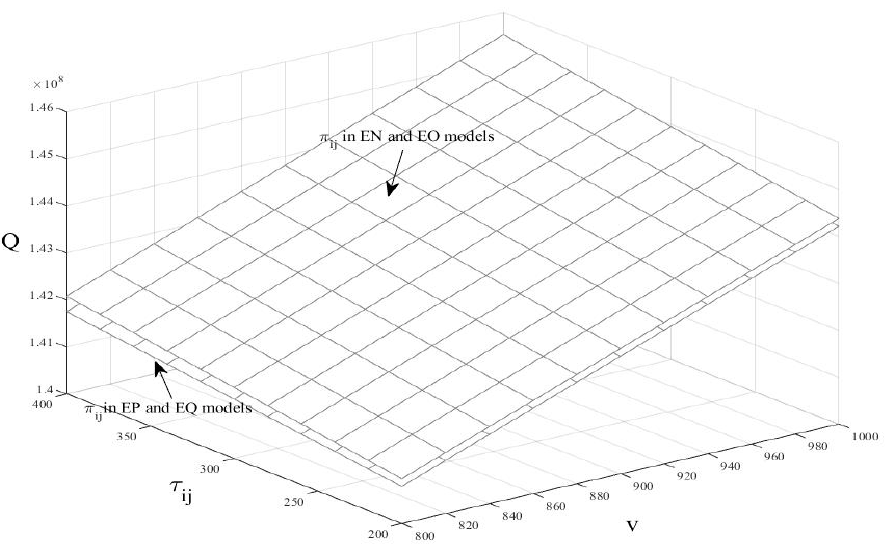
Figure 4. The impact of v and τ ij on π ij